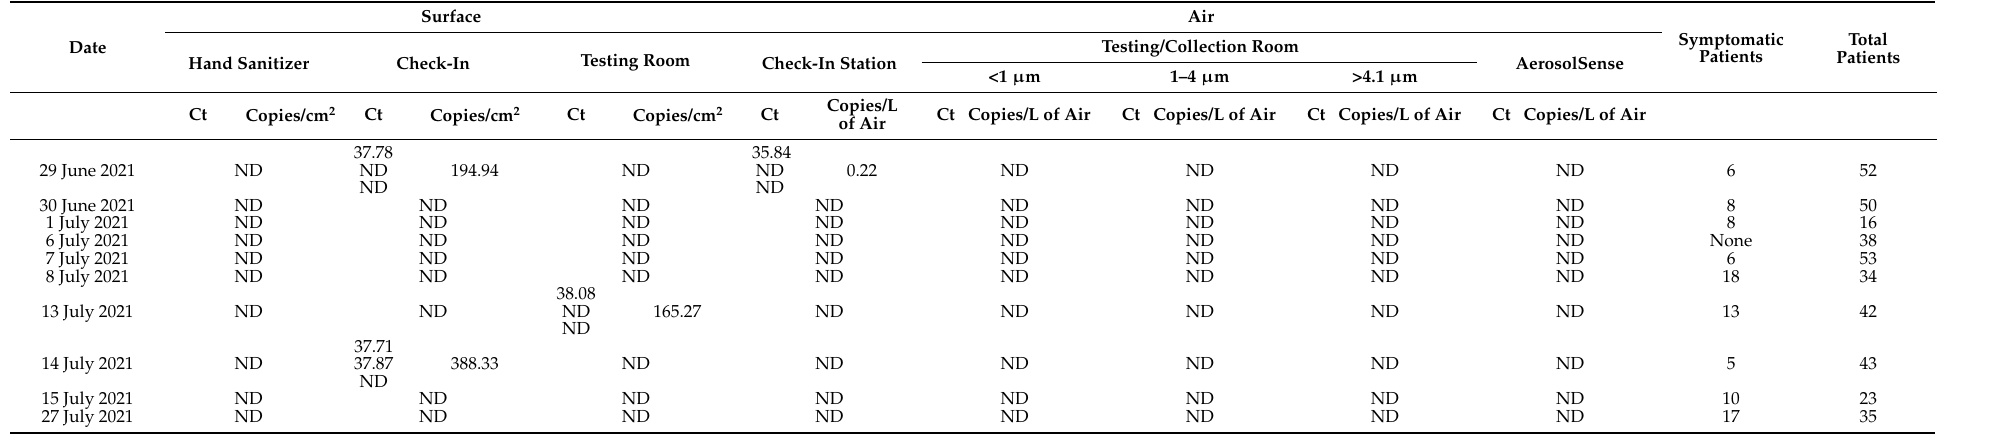
Table 1. Summary of RT-qPCR Ct values collected from the Nebraska Medicine satellite clinic. ND indicates non-detected samples. If all three technical triplicates were ND a summary result is provided. If mixed or quantitative detection was observed, the individual results were